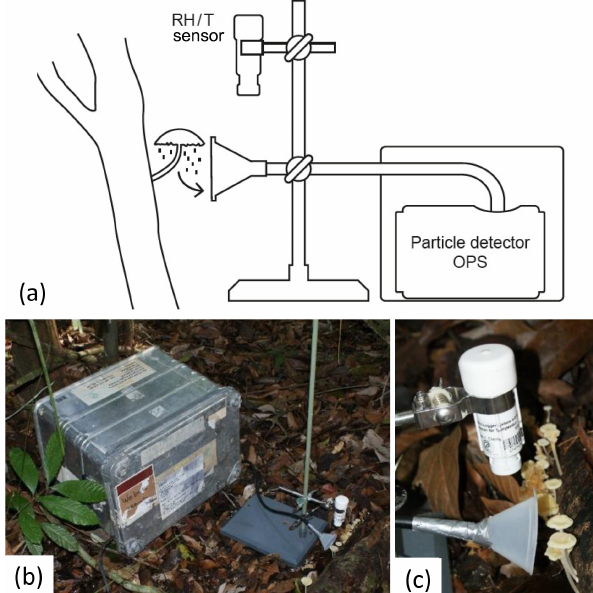
Figure 3. Setup used for field measurements. The optical particle sensor (OPS) is located in a box for weather protection. From this, an inlet ending with a funnel leads to the organism of interest. The setup is accompanied by a temperature and humidity (RH/ T ) sensor located in the direct vicinity of the sample. (a) Schematic drawing, (b) overview photograph, and (c) close-up photograph of the de- scribed